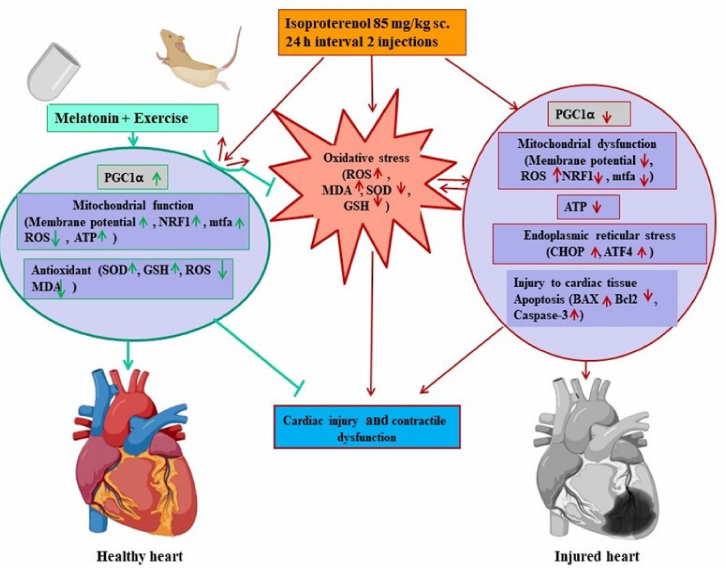
Figure 8. Schematic diagram of the proposed mechanisms by which melatonin and exercise counteract the challenges of isoproterenol-induced cardiac oxidative stress, injury, and contractile dysfunction. In rats, melatonin supplementation and exercise improved anti-oxidative activities, up-regulated PGC-1 α and mitochondrial biogenesis, and improved ATP, which may act in combination as reserve soldiers to counteract the challenges of isoproterenol-induced oxidative stress, down-regulation of PGC-1 α , mitochondrial function, ATP interruption, ER stress, and apoptosis, thereby preventing cardiac injury and contractile